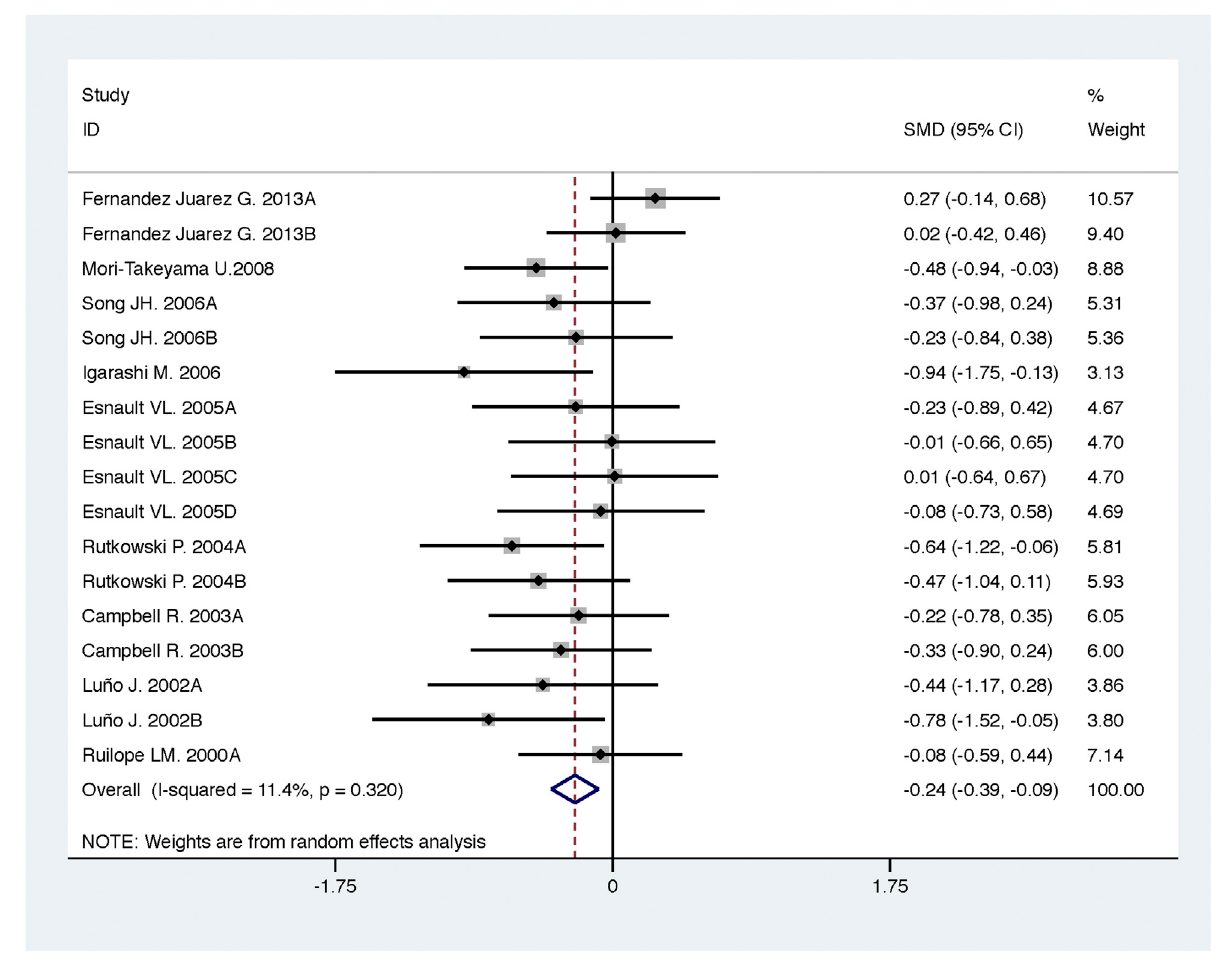
Frontiers in Pharmacology |